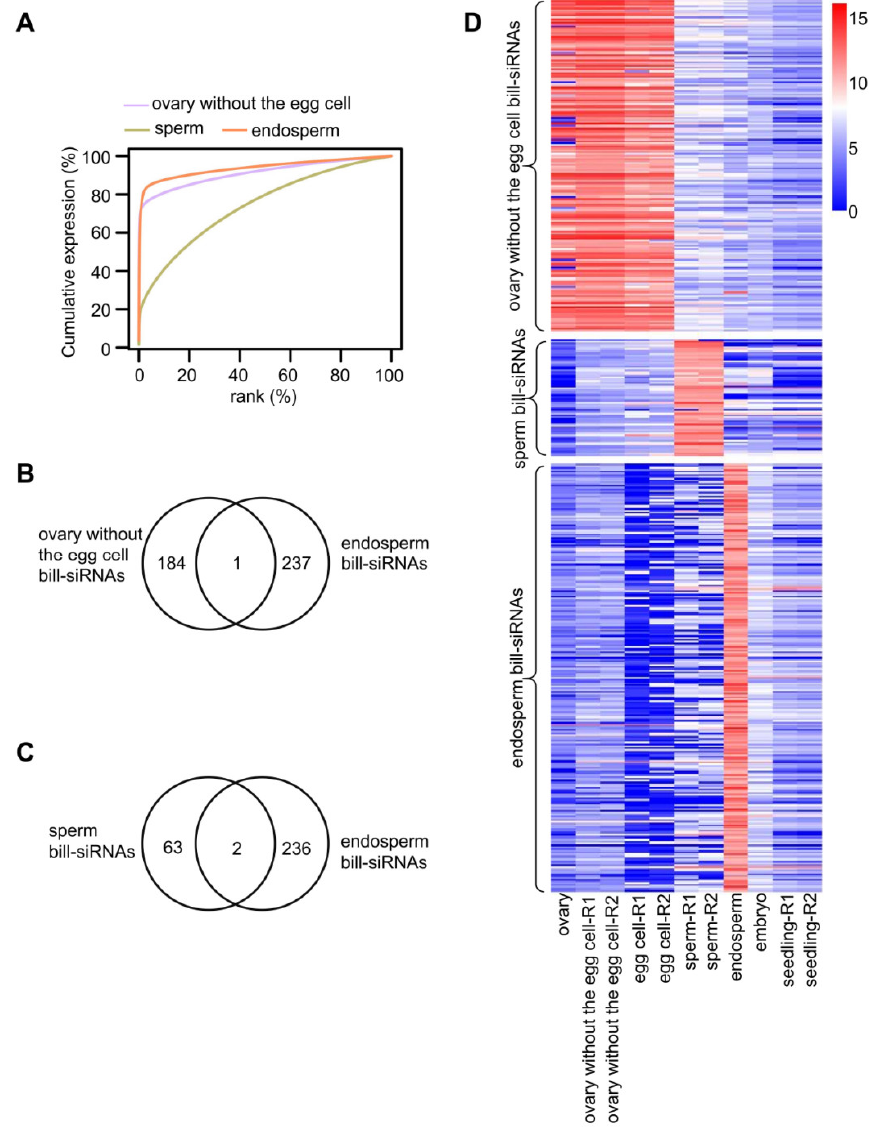
Figure 6. Endosperm produces new bill-siRNAs. ( A ) Cumulative expression plot of 24 nt siRNA clusters in the ovary without the egg cell, sperm, and endosperm. ( B ) Overlap between bill-siRNA clusters of the ovary without the egg cell and endosperm. ( C ) Overlap between bill-siRNA clusters of sperm and endosperm. ( D ) Heatmaps showing the siRNA abundance on bill-siRNA clusters in ovary, sperm, and endosperm.